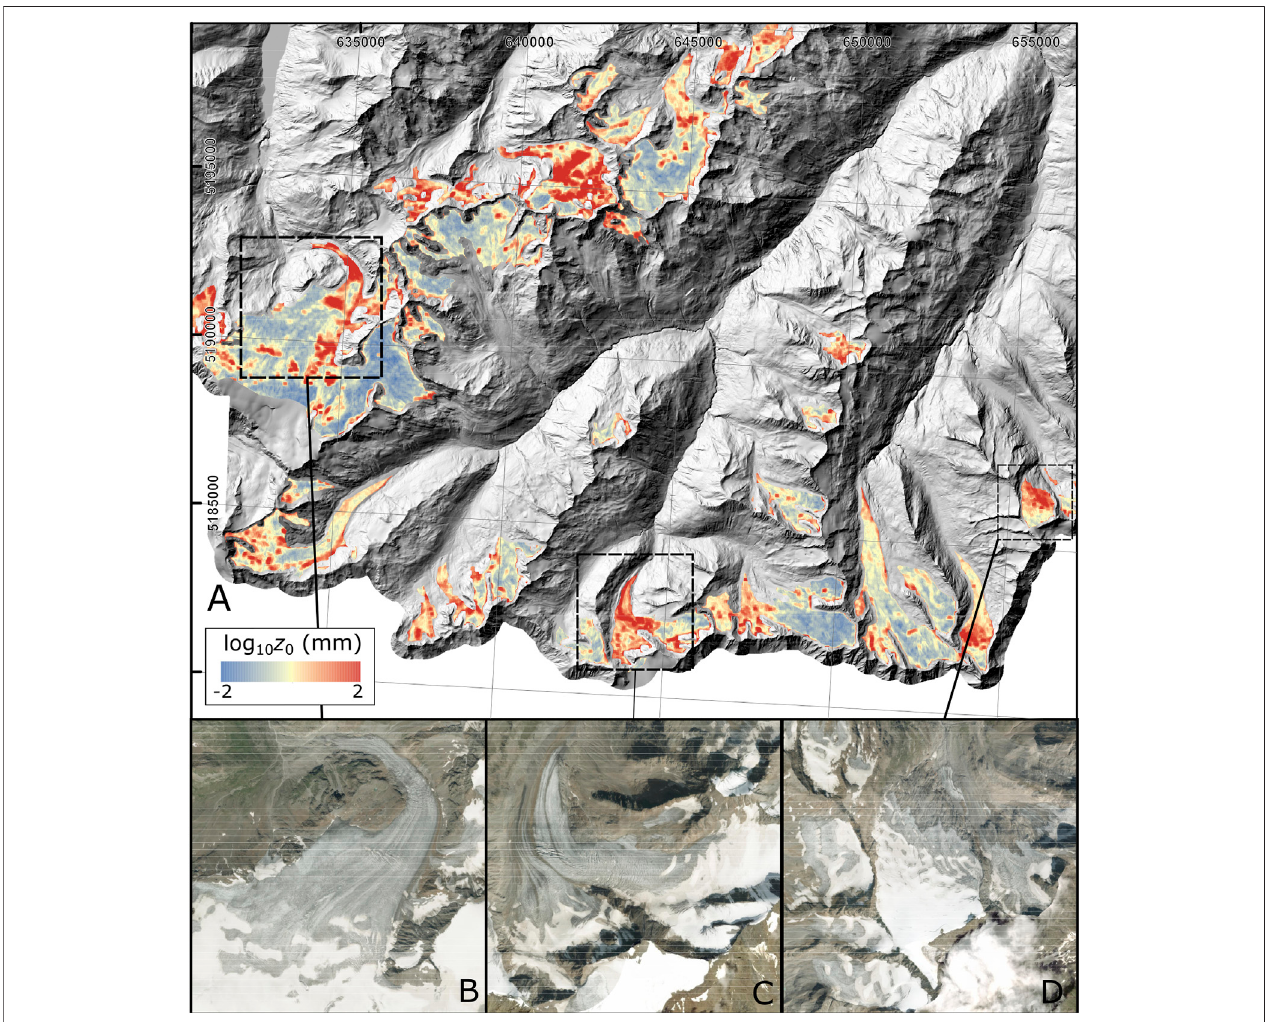
FIGURE 7 | Corrected z 0ALS for glaciers in the region around HEF (A) . Lower images show enlarged imagery of select glaciers, including (B) Gepatsch Ferner, (C) Marzellfernerand (D) Rotmoosferner(Source:ArcGISWorldImageryBasemap).ElevationdatafromOpenDataÖsterreich(Digitales10 m – GeländemodellausAirborne Laserscan Daten). Glacier outlines from Austrian Glacier Inventory 4 (Buckel and Otto, 2018). Glaciers restricted to those with area > 0.5 km 2 . z 0ALS calculated using 100 m neighborhoods. All z 0 is log 10 transformed.